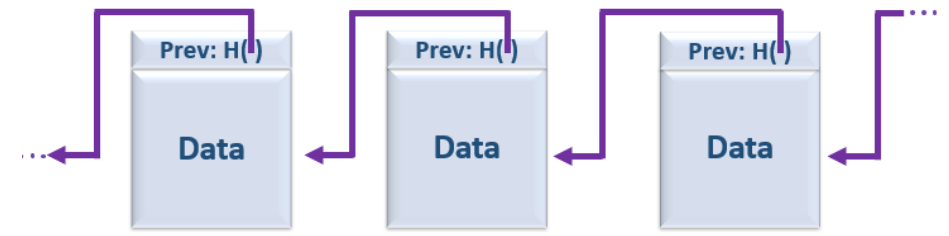
Figure 1. Blockchain data structure as a linked list of hash